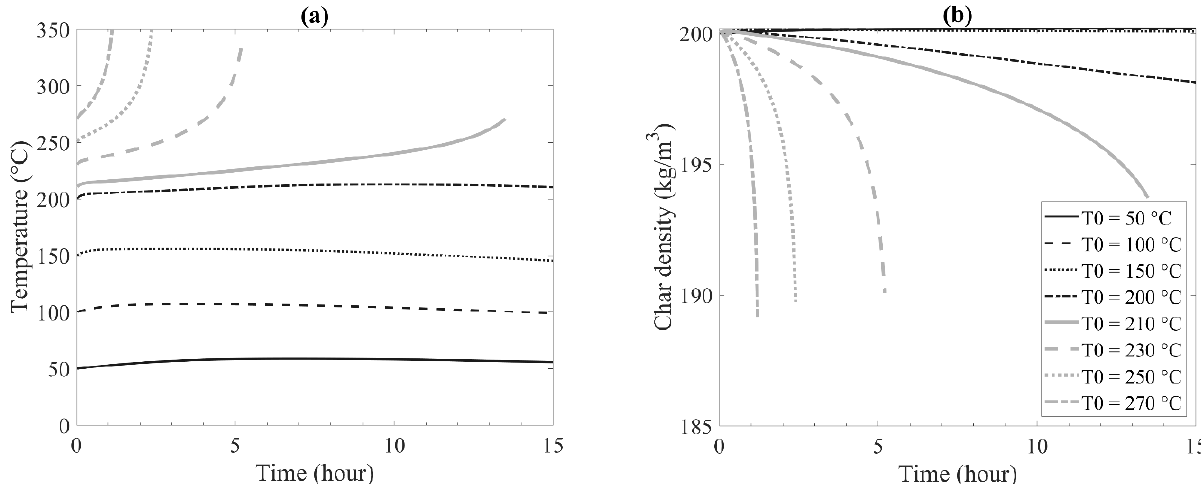
Figure 9. Effects of char initial temperature with the strorage condition of T ambient = 25 °C, ρ c ,0 = 200 kg m − 3 , and H container = 1 m: ( a ) on thermal runaway represented by the average char temperature; ( b ) on average char density.